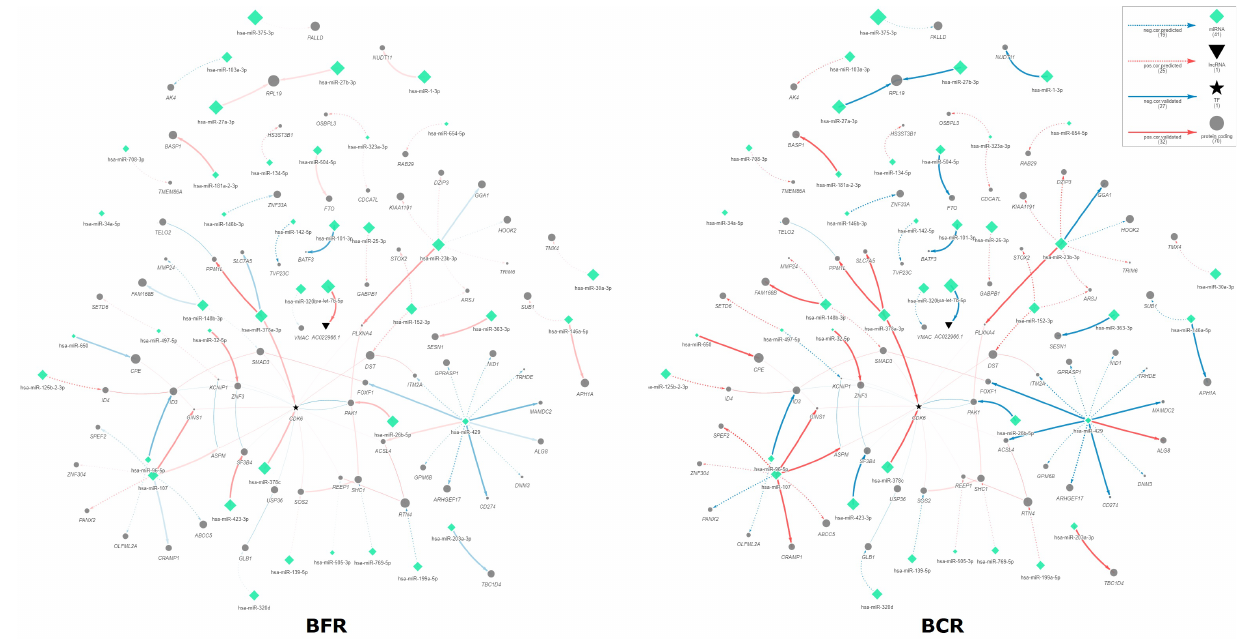
Figure 3. Interactome networks for BCR/BRF groups of the PCa TMPRSS2-ERG molecular subtype. BCR—biochemical recurrence group, BRF—biochemical recurrence-free